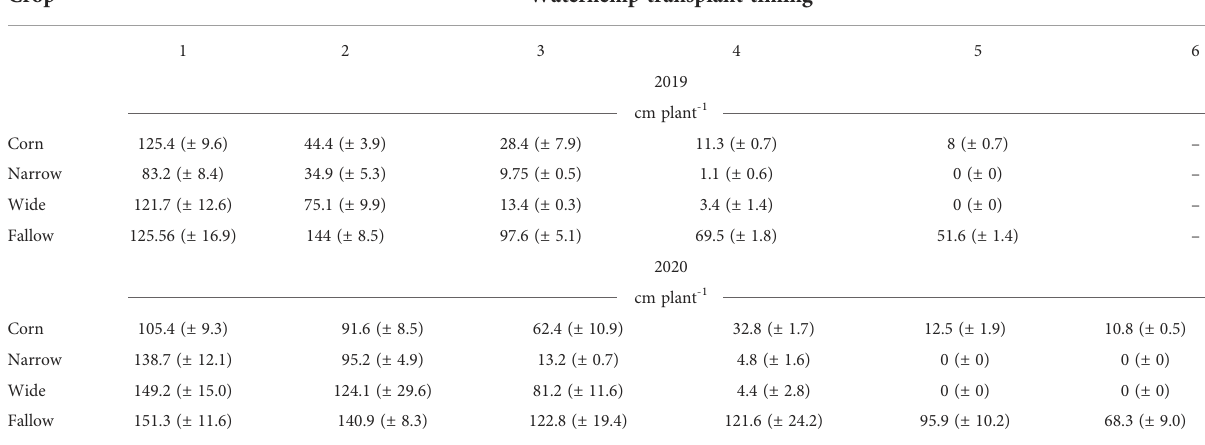
TABLE 4 The average height (cm plant -1 ) of harvested waterhemp plants per each crop and transplant timing in 2019 and 2020, respectively. a .